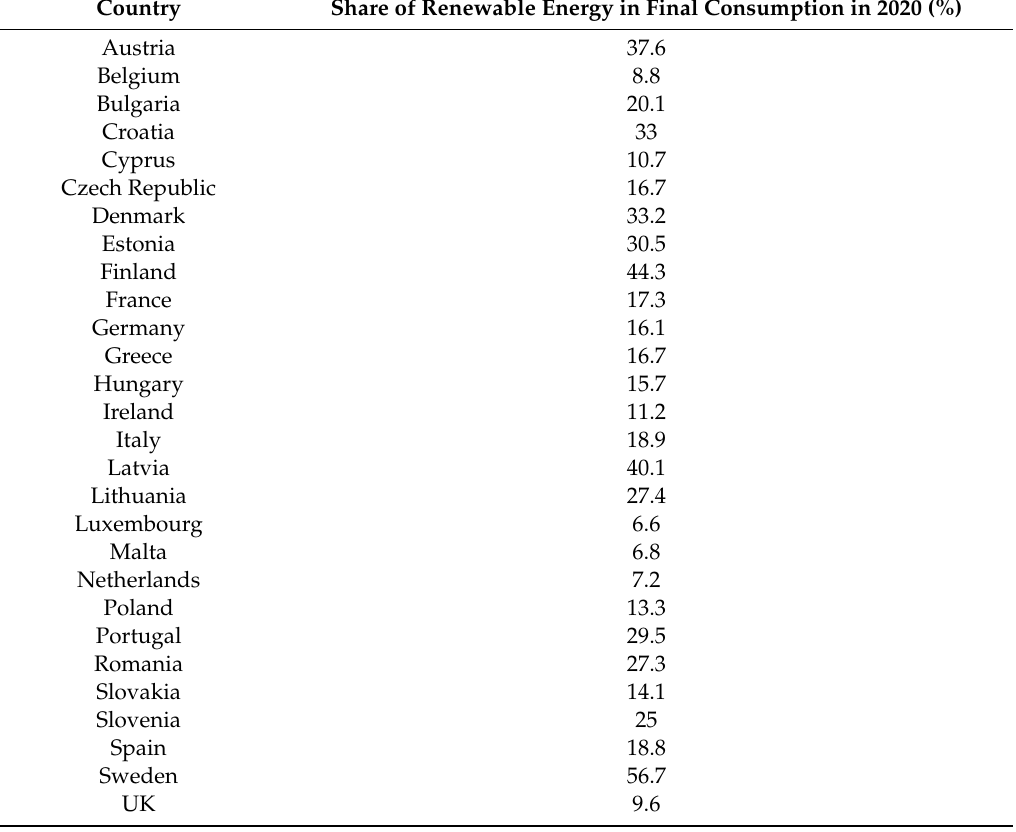
Table 5. Scenarios for the share of renewable energy in final consumption (%) in the EU-28 in 2020.